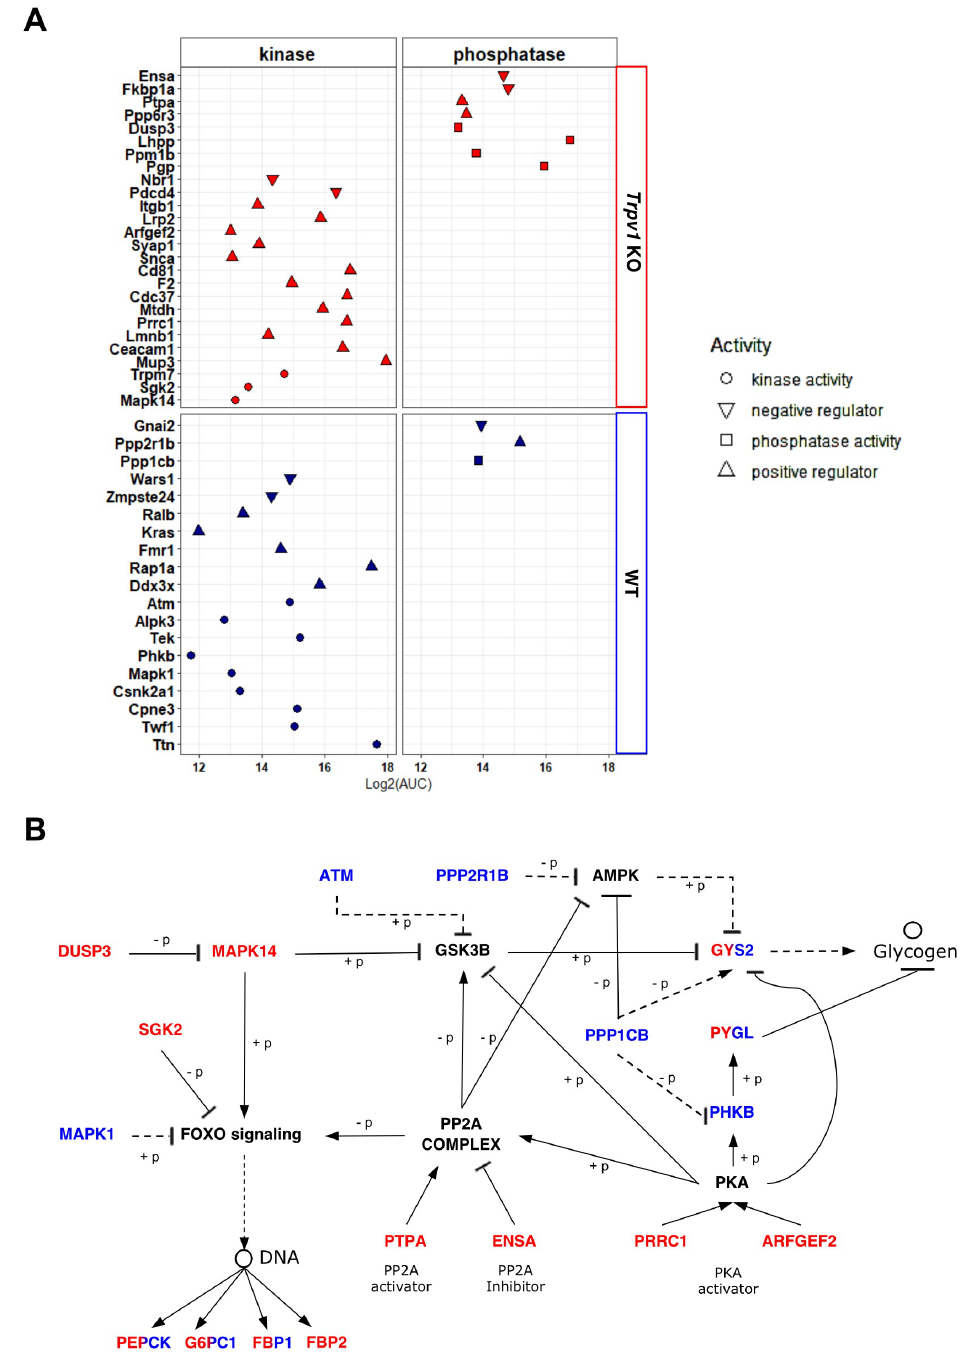
Figure 5. Network integration between kinases and phosphatases for modulation of hepatic glyco- genesis/glycogenolysis in the absence of TRPV1 channels. ( A ) Mapping of kinases, phosphatases, and their regulatory proteins exclusively identified in the liver of Trpv1 KO or WT mice or those that showed significant differences in the relative quantification by the LFQ approach. ( B ) Differentially identified kinases, phosphatases, and regulatory proteins of each proteome were integrated into the same network to identify mechanisms that were different between Trpv1 KO and WT livers. Blue color for proteins only found in the WT proteome, dual colors (blue/red) for proteins shared among proteomes, and black for proteins not found in the proteomic data. (+p) refers to phosphorylation and ( − p) to